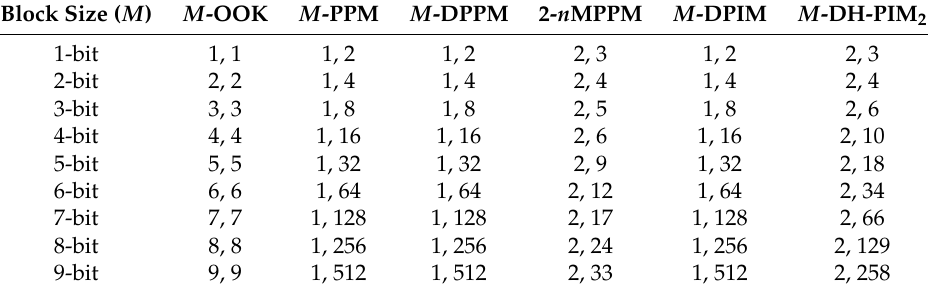
Table 10. Possible modulation schemes according to the size of the bit input block. Each cell expresses the modulated results as a 2-tuple is the maximum number of time